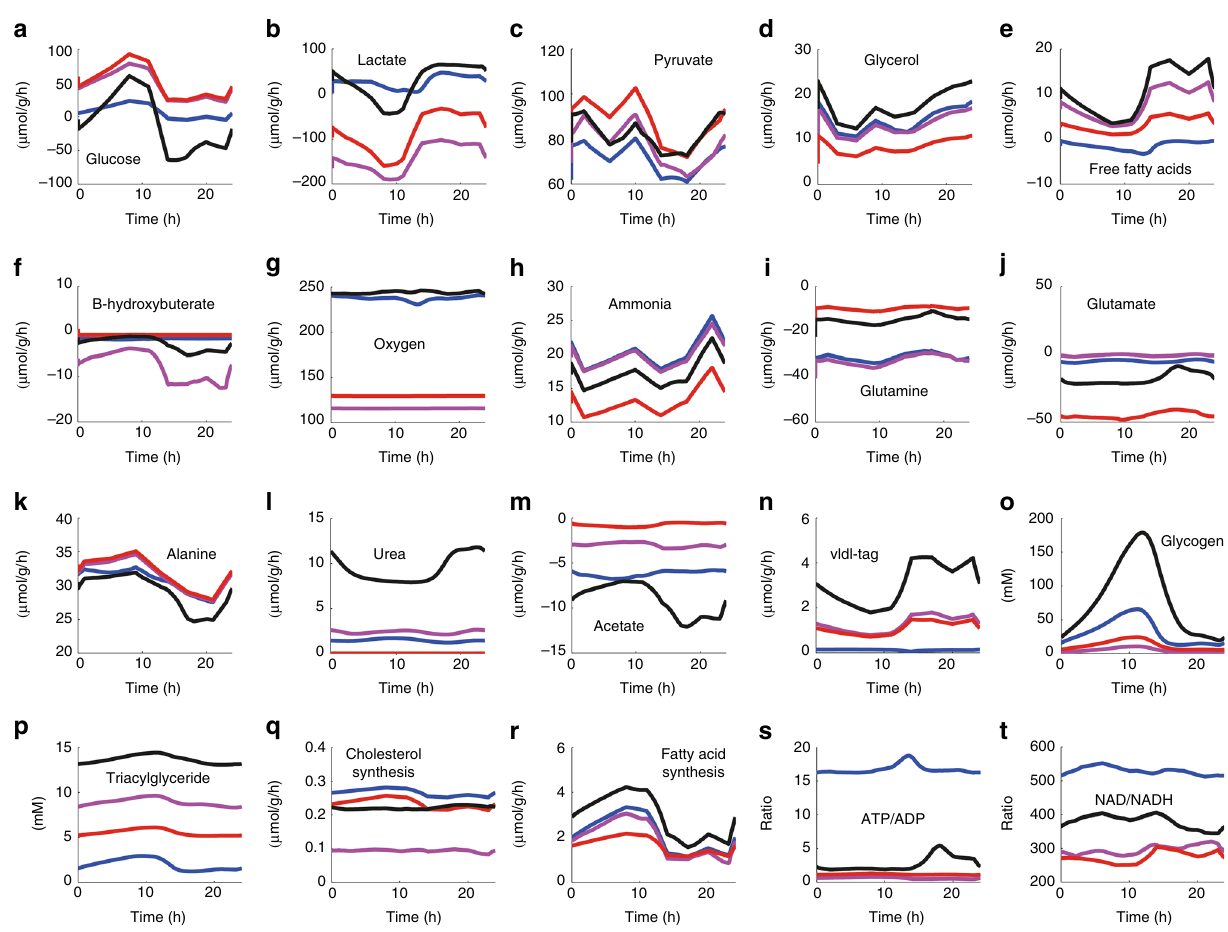
Fig. 9 Metabolic pro fi ling of liver tumors. Black lines: Normal hepatocyte. Red lines: T1 HCC, Pink lines: T3a HCC. Blue lines: Adenoma. The tumor tissues were obtained from three different patients and the proteome was determined by shot-gun proteomics. Relative protein abundances were used to scale maximal enzyme activities (Supplementary Data 3). The diurnal metabolite-hormone pro fi le used as model input was the same as in Fig. 2. a glucose exchange rate, b lactate exchange rate, c glycogen content, d pyruvate exchange rate, e glycerol exchange rate, f oxygen uptake rate, g ATP/ADP